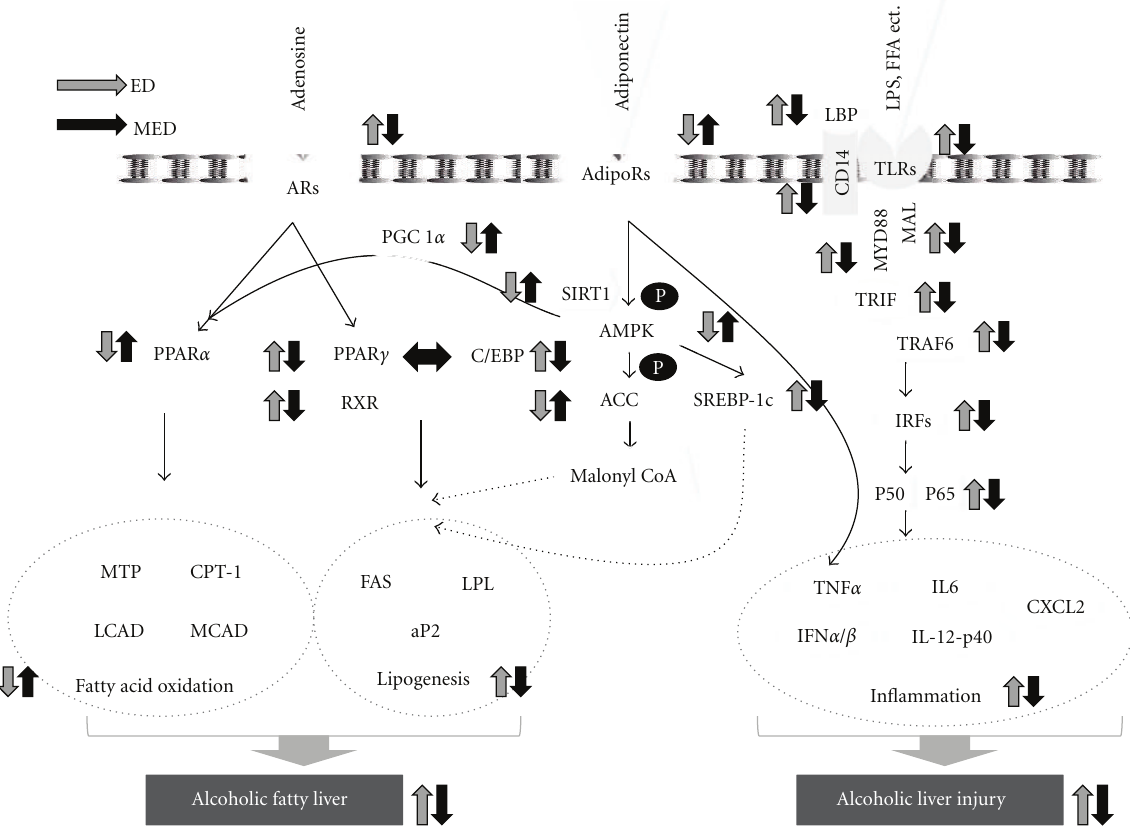
Figure 6: Schematic diagram illustrating the antilipogenic and anti-inflammatory activities of Codonopsis lanceolata in the liver of mice with chronic ethanol consumption. Adapted from Peng [1], You and Rogers [37, 51]. The arrows denote the direction of the responses to altered conditions with ED feeding relative to ND feeding (gray arrows), and with MED feeding relative to ED feeding (black